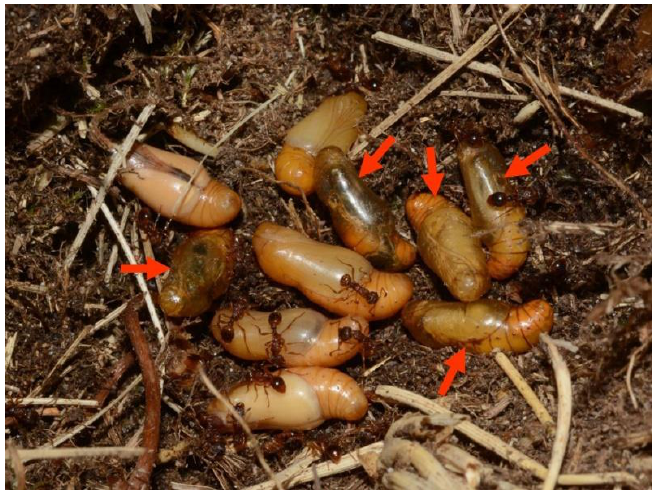
Figure 5. Myrmica ant species composition at the site of Phengaris alcon in the Białowieża Forest and proportion of Myrmica scabrinodis nests infested by the butterfly.